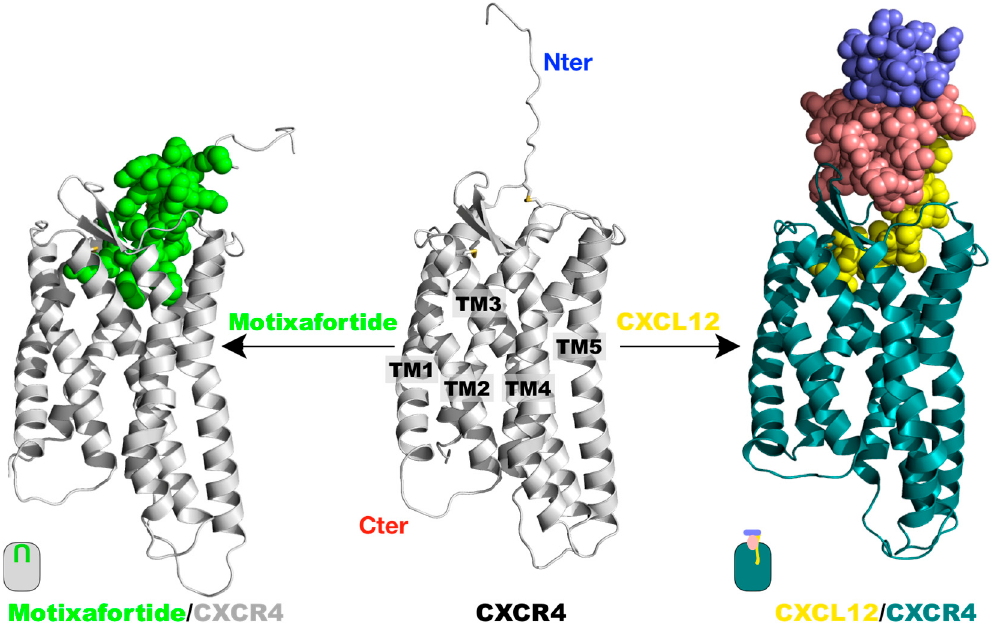
Figure 1. Protein complexes investigated: The tertiary structure of the CXCR4 receptor was taken from the X-ray structure with the PDB accession code 4RWS.pdb. A segment at the N-terminus was modelled as an extended structure (central panel). The same CXCR4 structure was utilized to generate the two protein complexes with either CXCL12 or motixafortide, by placing the ligands at the CXCR4 orthosteric binding site as described in the Materials and Methods section. The systems were embedded in a hydrated lipid bilayer and investigated by 1.0-microsecond-long unbiased MD simulations. A representative final structure of the motixafortide/CXCR4 complex is depicted in the left panel, where the CXCR4 structure is colored grey, while motixafortide is depicted as green spheres. In the right panel, an equivalent final structure of the CXCL12/CXCR4 complex is shown, where the CXCR4 receptor is colored teal, while the chemokine is presented as spheres using the same color code as in Figure S1.